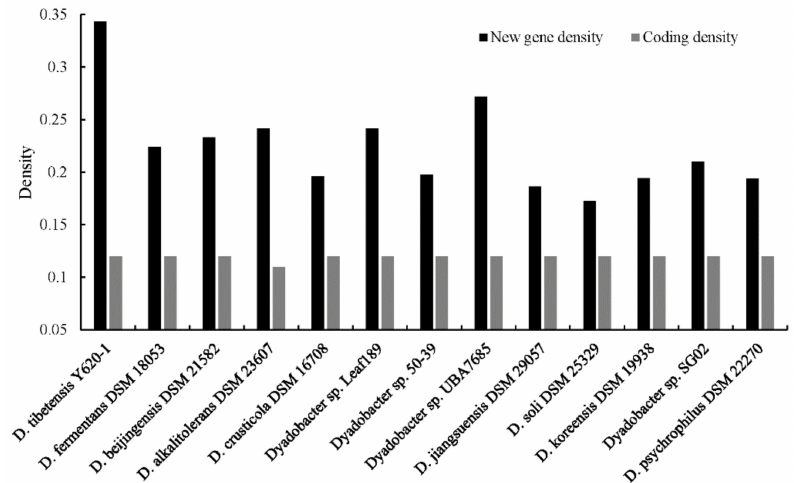
Figure 4. Bar graph showing the density of new genes and protein coding genes in each genome.